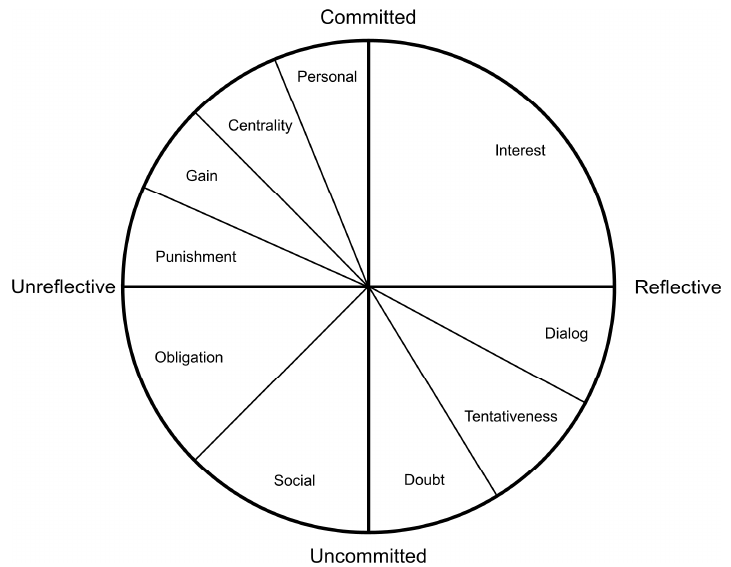
Figure 1. Krauss and Hood’s (2013) theoretical multidimensional Commitment-Reflectivity Circumplex